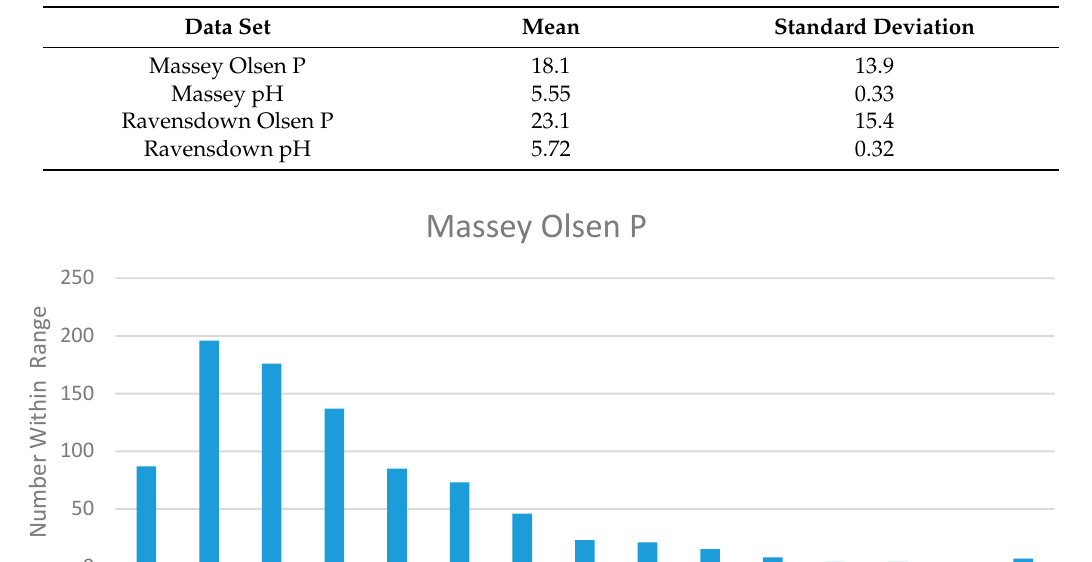
Table 1. Mean and standard deviations of the two data sets.